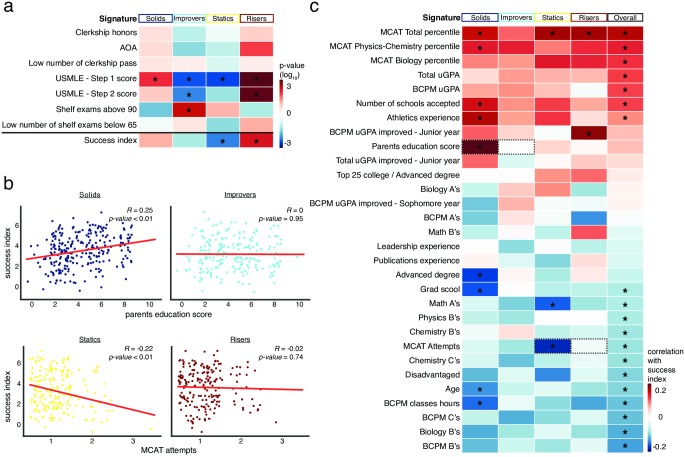
The relationship between student signatures and their success in medical school.(a) Signatures show different levels of success. For each signature, the heat-map indicates the significance of the average level of a success measure relative to the average level in a randomly selected group of the same size. The ‘success index’ shown in the last row is a combined score of the above outcomes (see Materials and methods). Stars indicate P-value less than 0.01. (b) Parent education score and the number of MCAT attempts predict success differently across signatures. The two upper plots show the correlation between parent education score and the success index for solids (left) and improvers (right). The two bottom plots show the correlation between the number of MCAT attempts and the success index for statics (left) and risers (right). The points were jittered to better show the points. (c) Different features differentially predict success across signatures. The heat-map summarizes the correlations between the features and signatures. Only features with a minimal absolute Pearson correlation coefficient of R > 0.1 in one of the signatures or overall are shown. Stars indicate P-value less than 0.01.